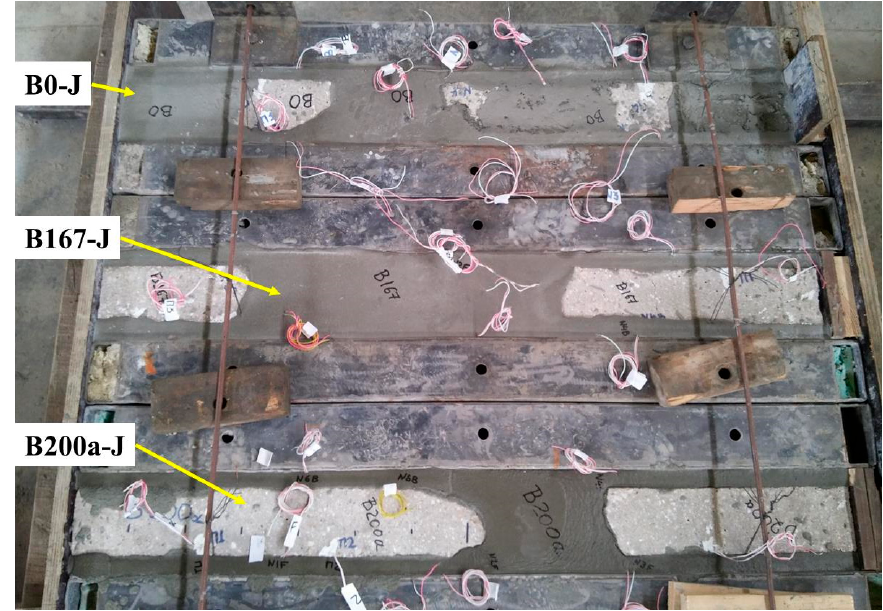
Figure 7. Casting of the U-shaped jackets using a flowable cementitious mortar grout matrix.